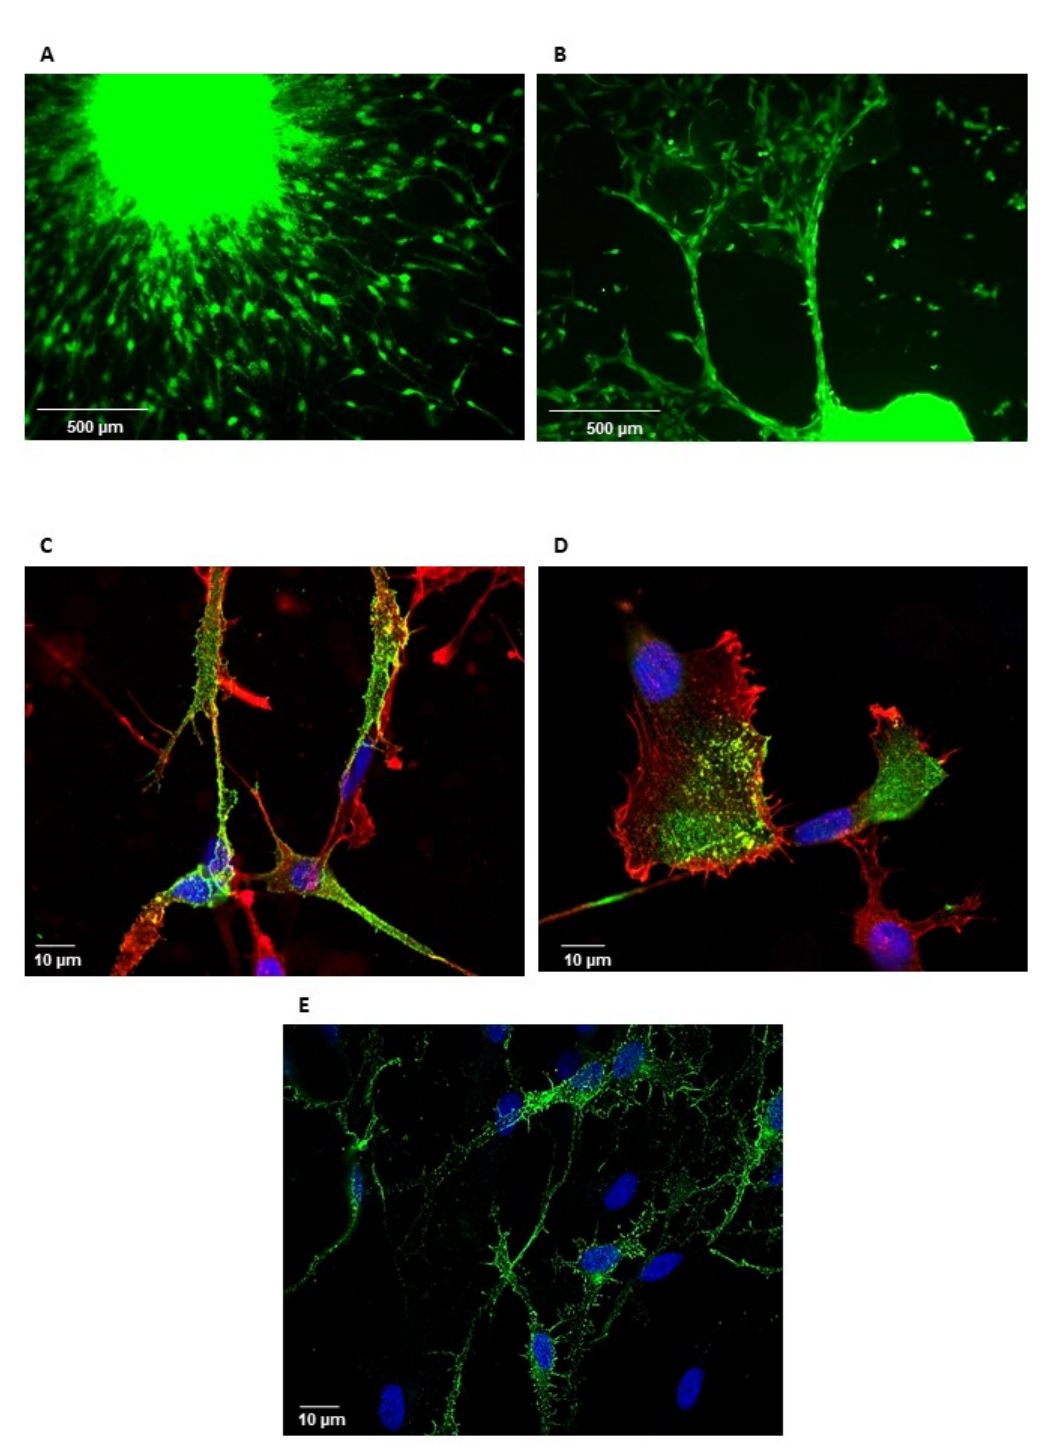
Figure 3 . Immunofluorescent staining of GPM6A in invasive GBSC. Invasive neurospheres seeded in Lab-Tek chamber slides coated with Matrigel were immuno-stained with anti-GPM6A antibodies (green) and incubated with phalloidin (red) or Dapi (blue) as described in “Methods”. ( A , B ) Immunofluorescence stainings were analyzed on a Nikon Eclipse Ti with the Nikon software NIS Element AR (original magnification 10 × ). ( C – E ) Immunofluorescence stainings were analyzed and on a LSM 880 Fast Airyscan-Zeiss inverted confocal microscope with the Zeiss software Zen 2 (original magnification 60 ×